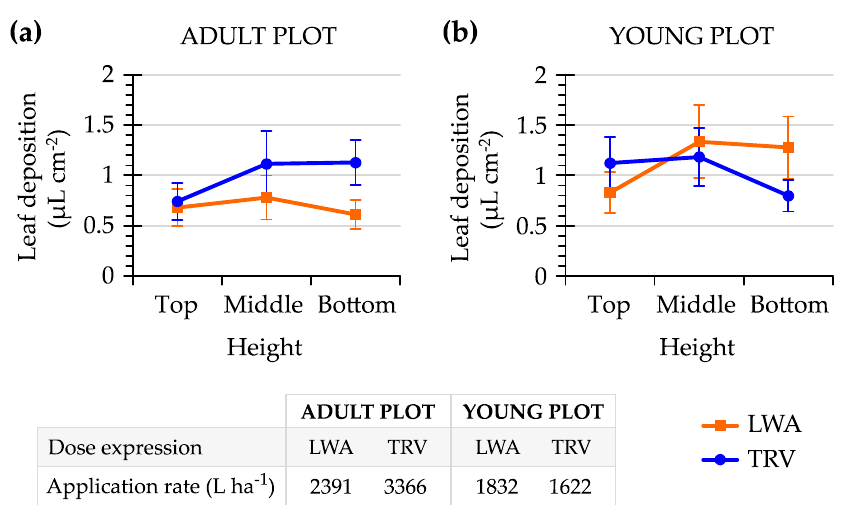
Figure 9. “Dose Expression × Height” interaction for leaf deposition ( μ L cm − 2 ) (mean (s.e.)) for the ( a ) adult and ( b ) young plots.